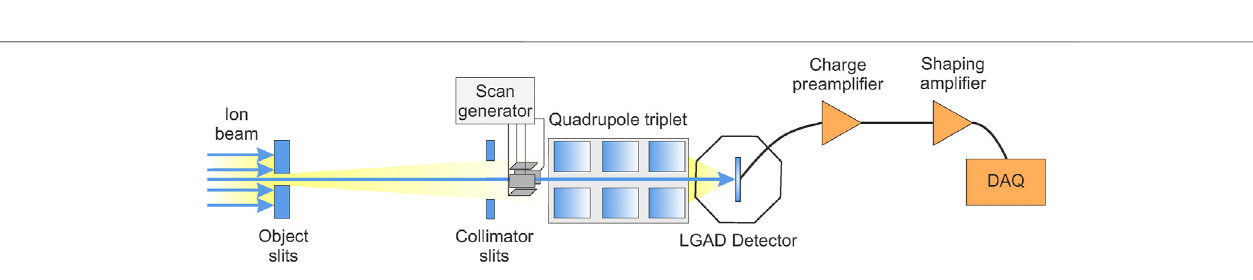
FIGURE 2 | Schematic presentation of the ion microprobe focussing and scanning system with IBIC pulse processing electronic chain. Charge sensitive preampli fi er used was Ortec 142A, while the ampli fi er was Ortec 570. Data acquisition was based on Canberra ADC 8701 and in house made SPECTOR software.